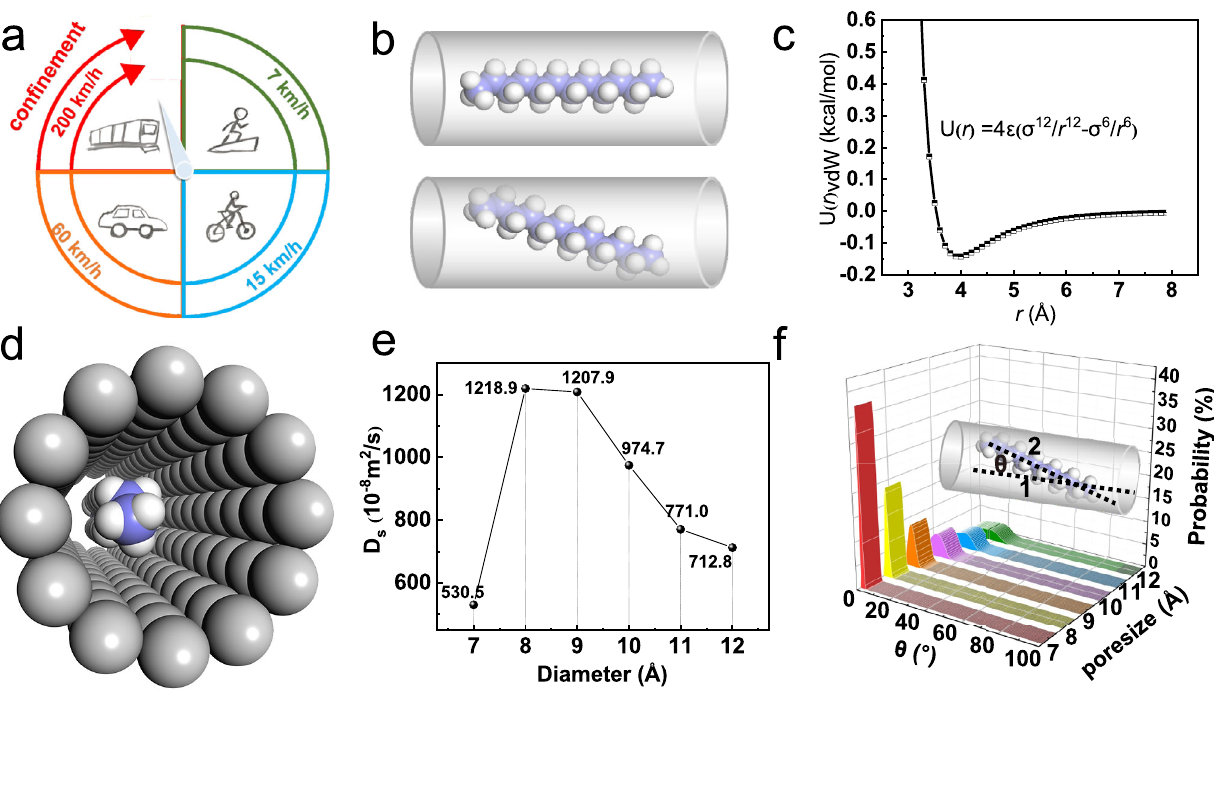
Fig.1 |Hyperloop-likediffusionundercon fi nement.a Examplesof movementin daily life. b Schematic showing n-dodecane (C12) molecule transport in zeolite channels on the right track (top) and deviating from the track (bottom) . c Van der Waals interactions between C12 and zeolite. d Stereogram model of the C12 molecule in the nanometer channel. e The diffusion coef fi cients of C12 in the